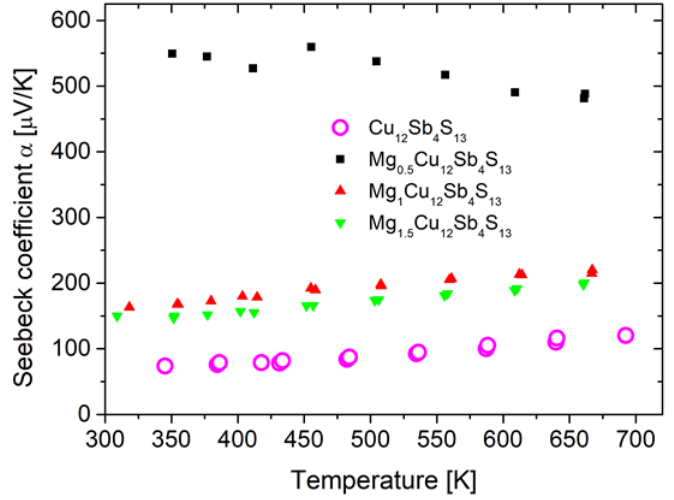
Figure 12. Temperature dependence of the Seebeck coefficient for Mg x Cu 12 Sb 4 S 13 sintered samples.